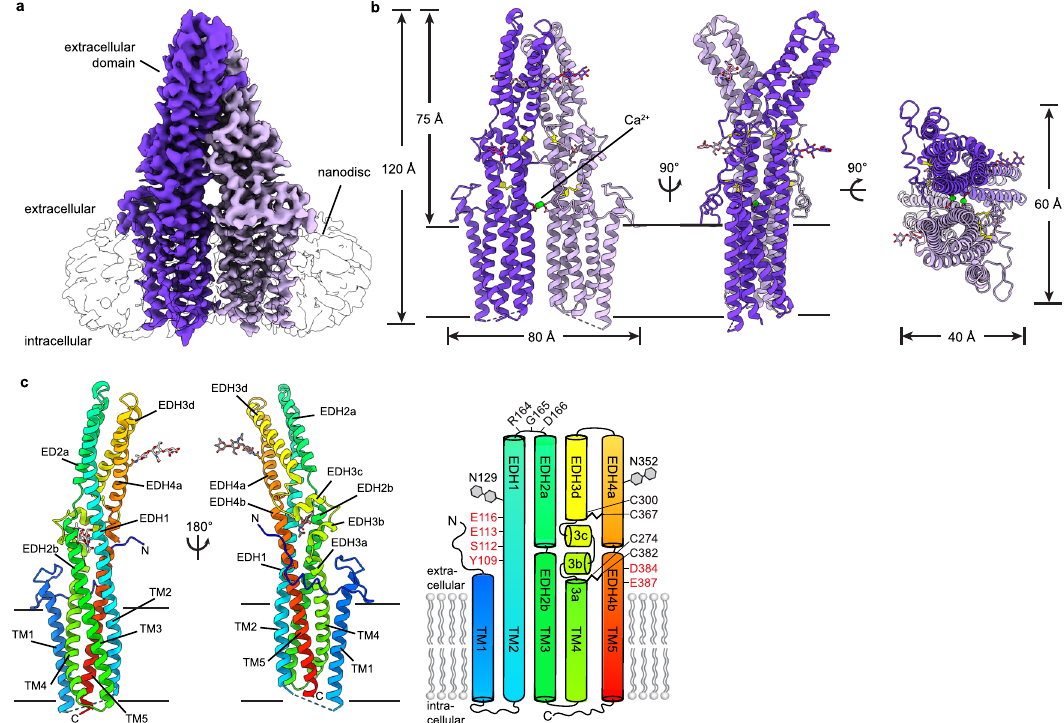
Fig. 1 Structure of a TTYH2 cis -dimer in the presence of Ca 2 + . a Cryo-EM map of a TTYH2 cis -dimer in MSP1E3D1 nanodiscs in the presence of Ca 2 + at 3.3 Å resolution viewed from the membrane plane. Density from the TTYH2 protomers is colored dark and light purple and the nanodisc is white. b Model of the TTYH2 cis -dimer viewed from the membrane and extracellular side. N-linked glycosylation sites and disul fi de bonds in the extracellular domain are drawn as sticks and Ca 2 + ions are shown as green spheres. c A TTYH2 protomer viewed from the membrane plane and cartoon illustration of domain topology with rainbow coloring from blue (N-terminus) to red (C-terminus). Positions of disul fi de bonds, glycosylation sites, and residues discussed in the text are